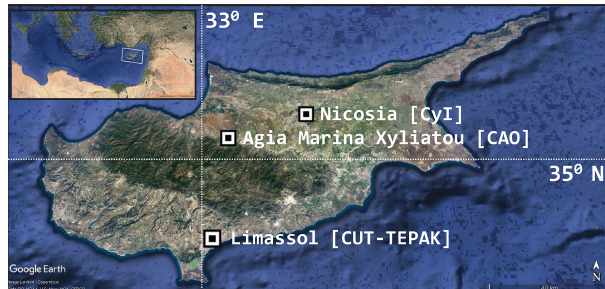
Figure 1. Landasat/Copernicus image of Cyprus with the main field sites of the Cyprus-2015 and CyCARE campaigns. The in- set shows the greater area of the eastern Mediterranean, Middle East, and northern Africa. (© Google Earth; data provider: Scripps Institution for Oceanography (SIO), NOAA, US Navy, National Geospatial-Intelligence Agency (NGA), General Bathymetric Chart of the Oceans